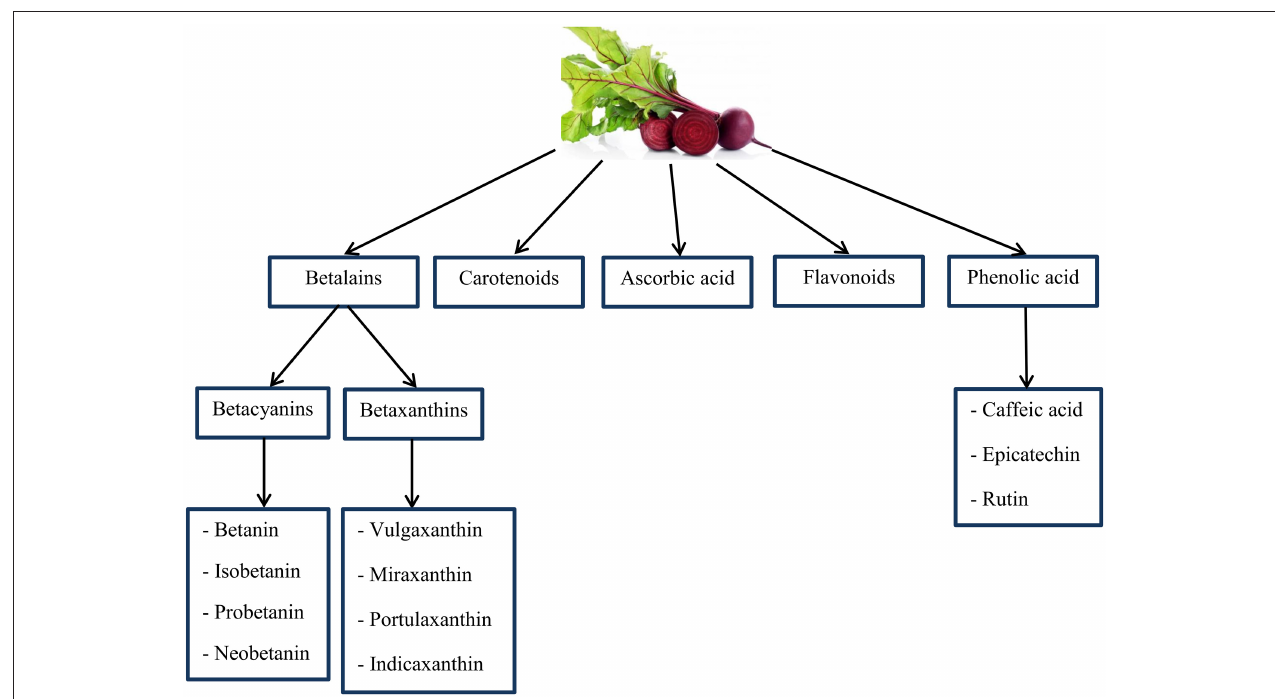
FIGURE 5 | An overview of important chemical compounds in Beetroot that may have antioxidant properties. Source: Georgiev et al. (165); Kujala et al. (166); Wootton-Beard and Ryan (167); Lee et al. (168); Vulic et al.